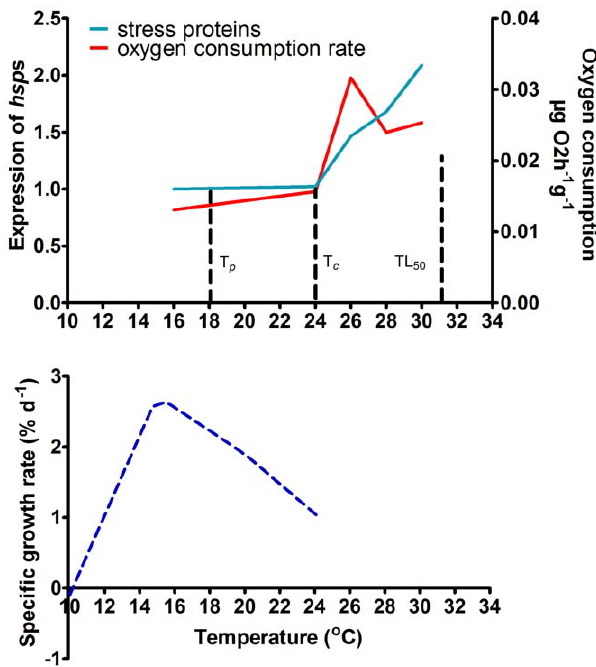
Figure 4. The variation trend of expression of hsp s, oxygen consumption rate and specific growth rate (SGR) with temper- ature increase in the sea cucumber Apostichopusjaponicus . Pejus temperature (T p ), which is the limit of optimum hemolymph oxygenation and therefore temperatures above this will result in a worsening of oxygen supply to the organism; critical threshold temperatures (T c ) where the mitochondrial metabolism transforms to an anaerobic mode (Reference 28). The specific growth rate (SGR) data are cited from previous studies (references 16, 18), and the temperature lethal to 50% of the samples (TL 50 ) after 2 h exposure was cited